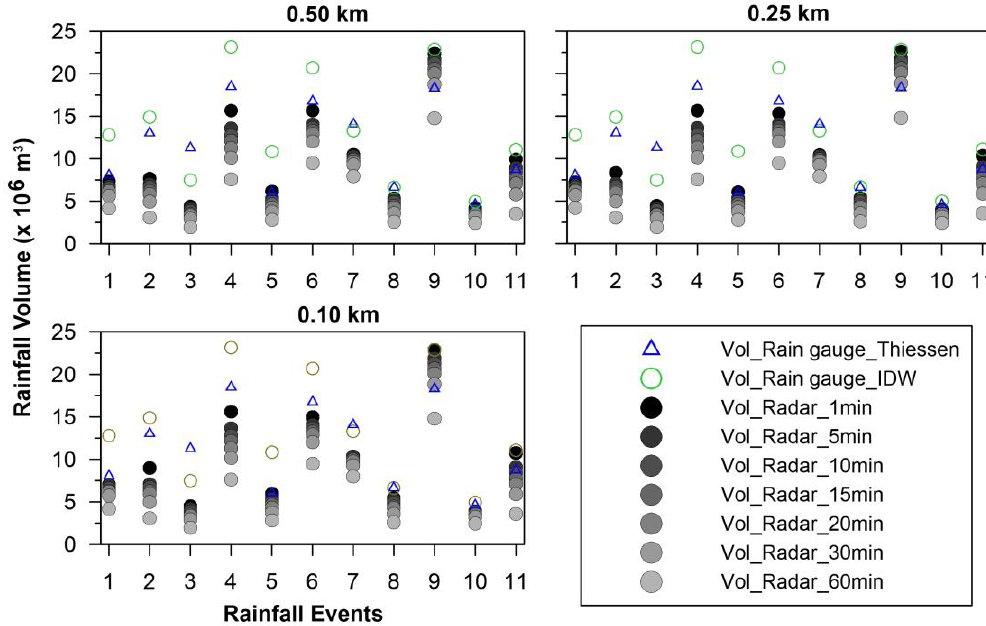
Figure 10. Accumulated rainfall volume (m 3 ) for the 11 events according to the different radar temporal and spatial resolutions.